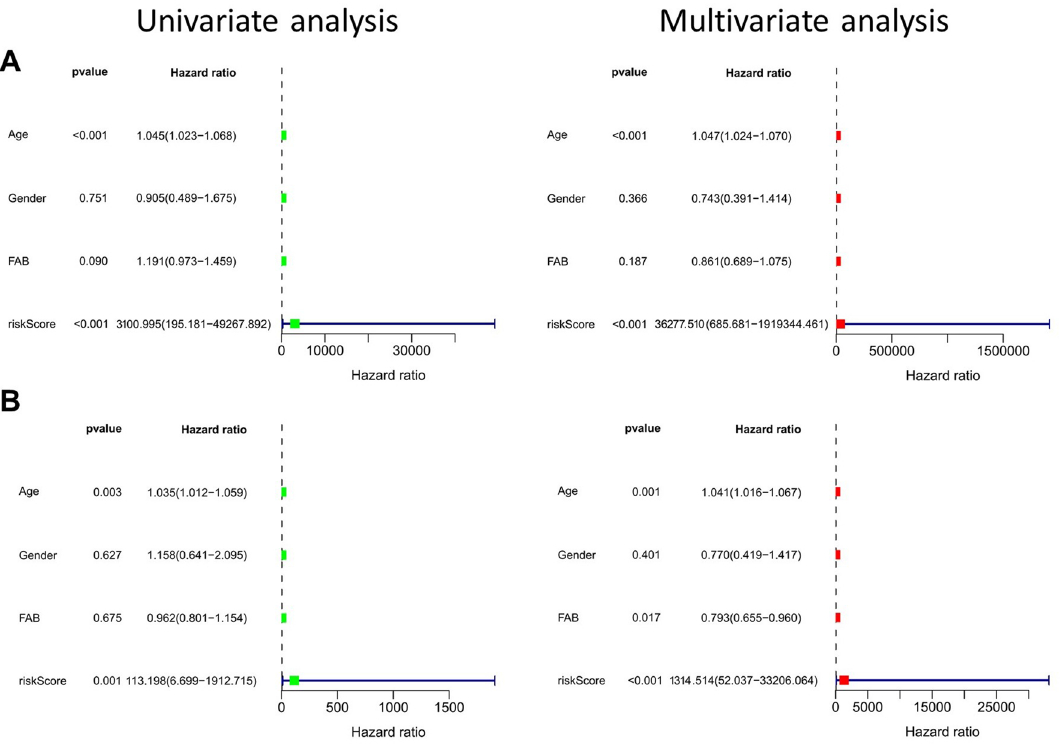
Figure 8. Identification of independent prognostic factors in AML cohort. Univariate and multivariate independent prognostic analyses of clinicopathologic factors and risk scores were conducted using the training set ( A ) and the test set ( B ).